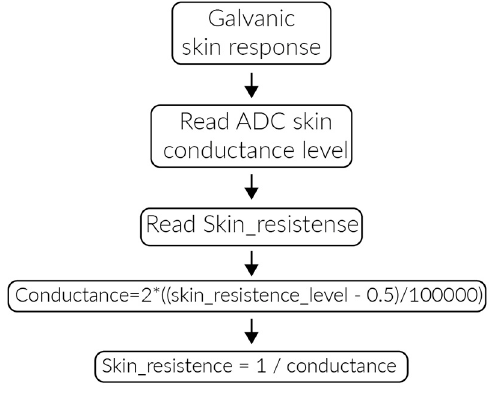
Figure 6. Galvanic skin response monitoring algorithm.